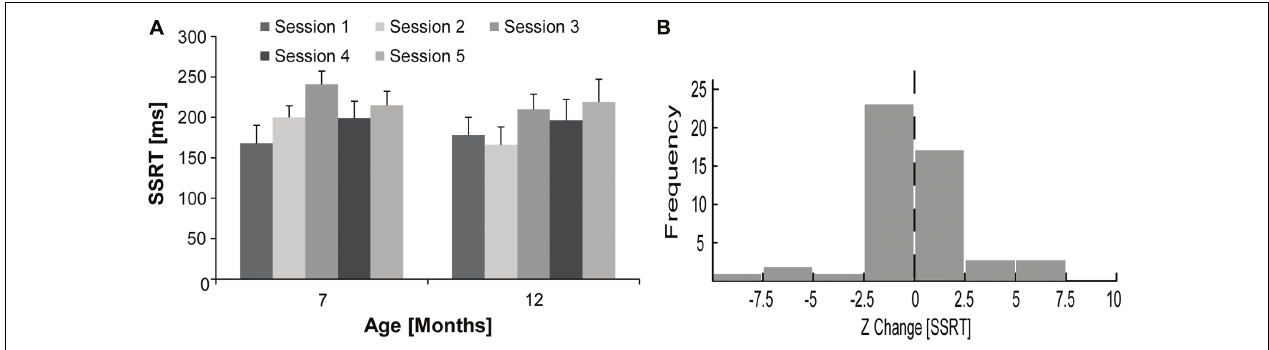
FIGURE 3 | Stop signal response time for rats at 7 and 12 months of age. (A) Mean ± SEM SSRT in five individual countermanding task sessions (light–dark gray) for rats ( N = 10) at 7 and 12 months of age. (B) Frequency distribution ( n = 50) for the Z change in SSRT for rats ( N = 10) comparing mean SSRT in five individual sessions at 12 months of age to their overall mean SSRT over five sessions at 7 months of